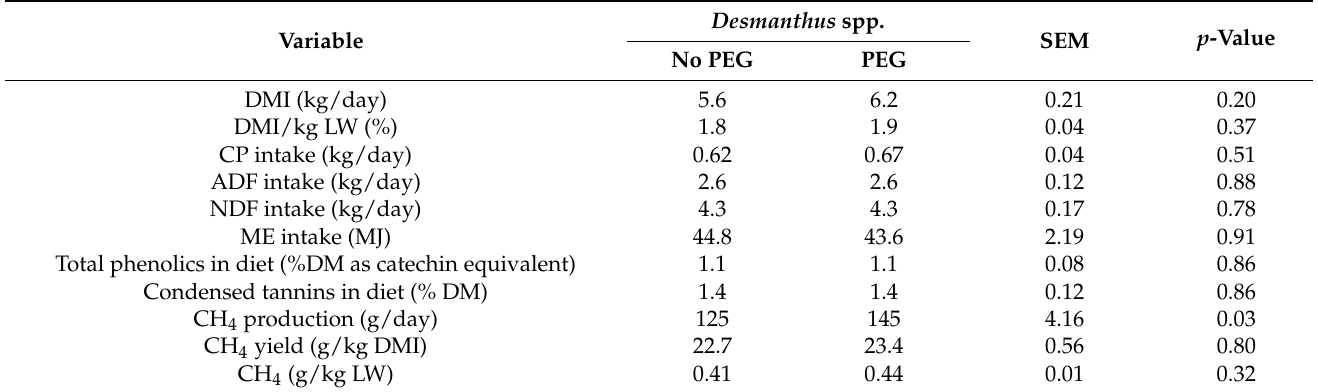
Table 4. Effect of polyethylene glycol on intakes and methane emissions.